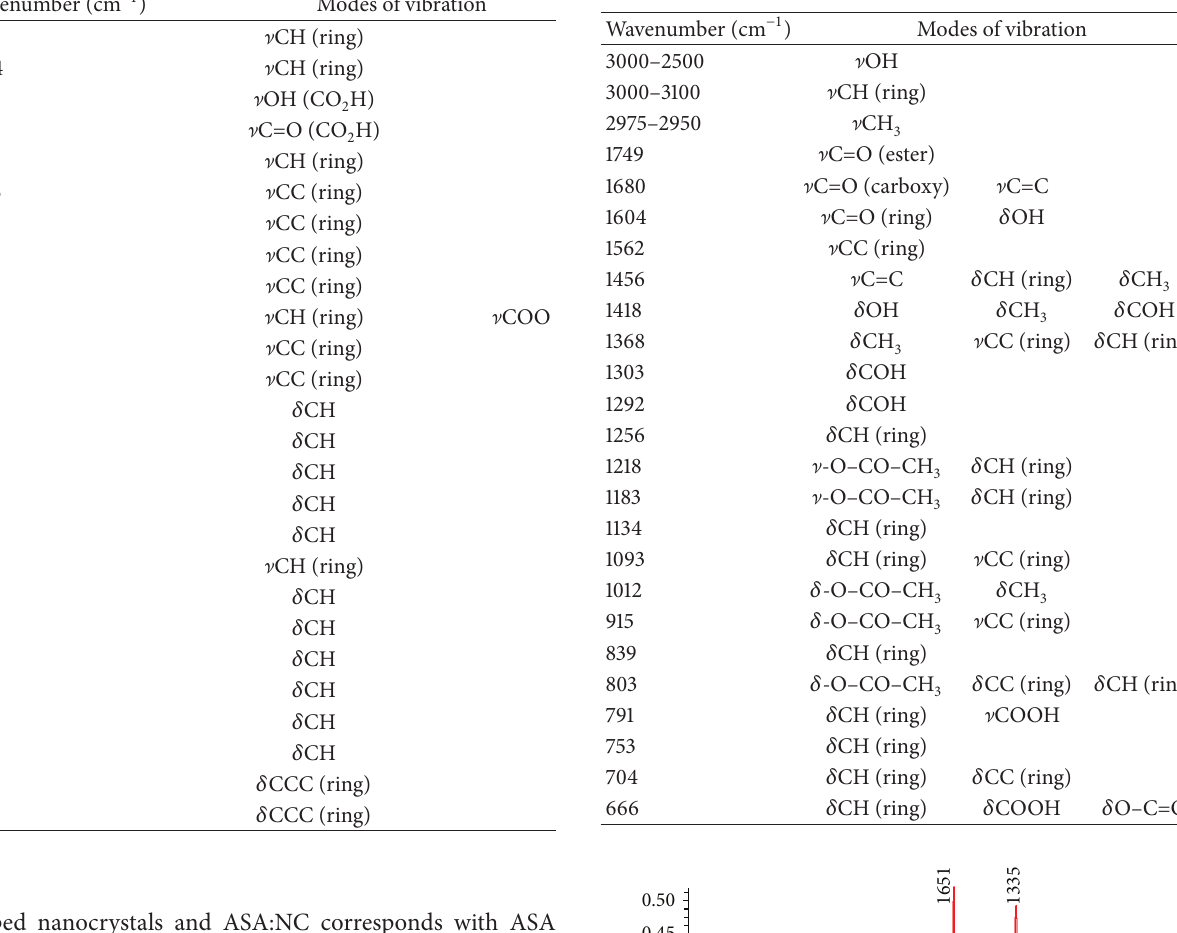
Table 2: Observed vibrational modes for acetylsalicylic acid [28– 34].